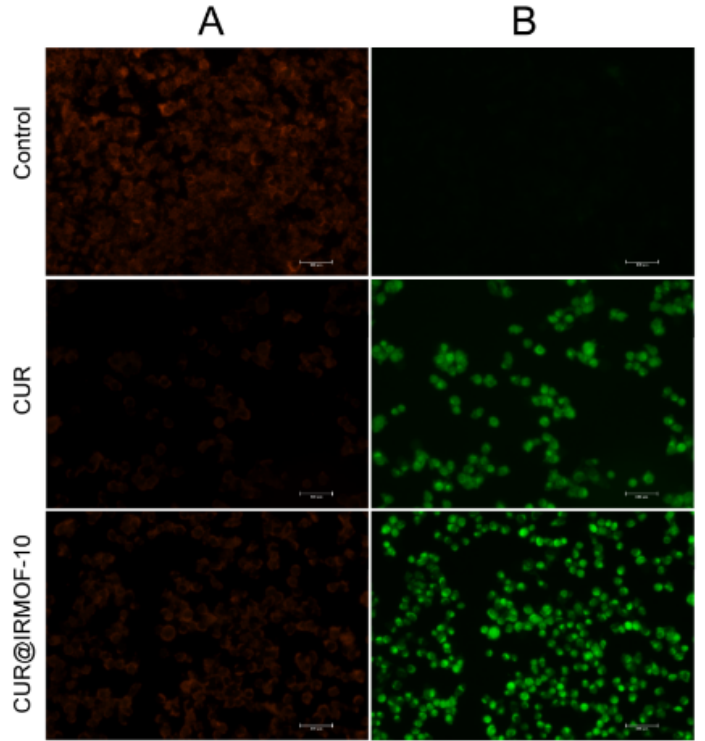
Figure 12. Effect of CUR and CUR@IRMOF-10 on the mitochondrial membrane potential of HepG2 cells. Red fluorescence represents the aggregate form of JC-1 ( A ); green fluorescence represents the monomeric form of JC-1 ( B ) (administered concentration calculated based on IC 50 of CUR).